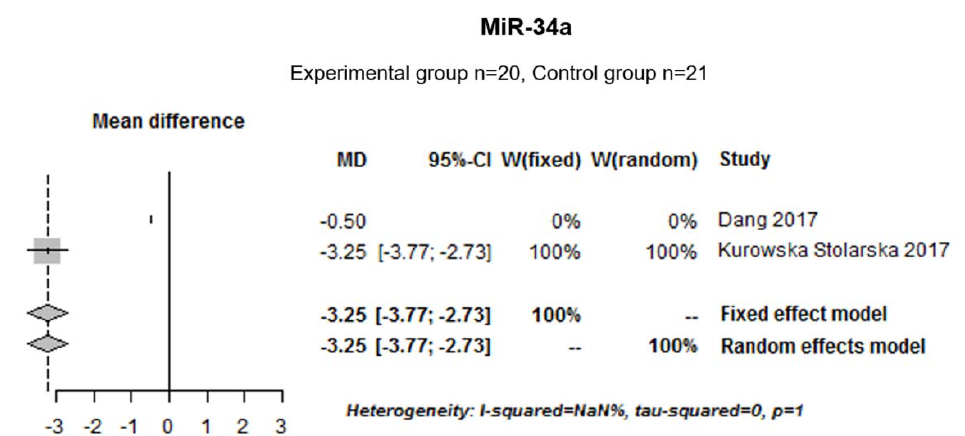
Figure 5. Forest plot meta ‐ analysis for the effect of miR ‐ 34a inhibition on arthritis score (murine model).